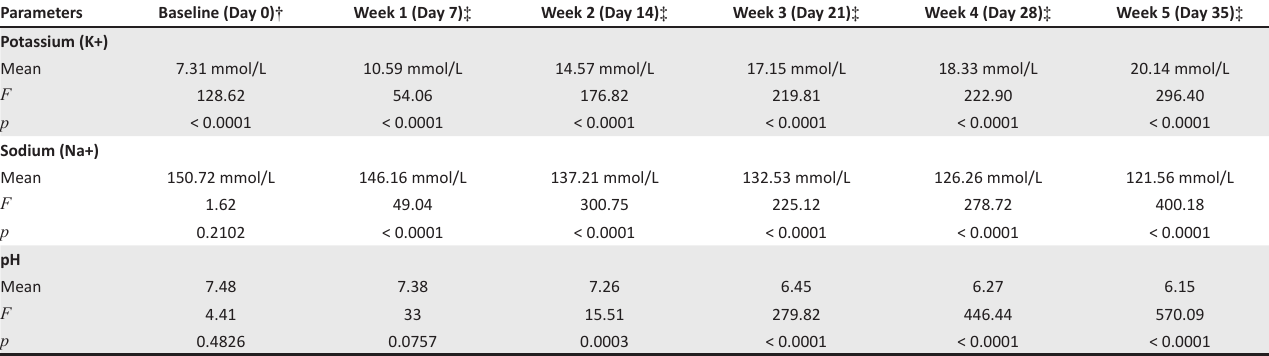
TABLE 1: Biochemical changes in blood throughout the blood storage period at Bungoma County Referral Hospital, Kenya, February 2019 to August 2019. Parameters